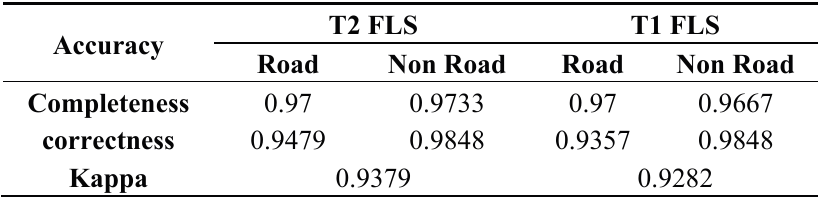
Table 4. Tuned FLSs accuracy evaluation for the training data